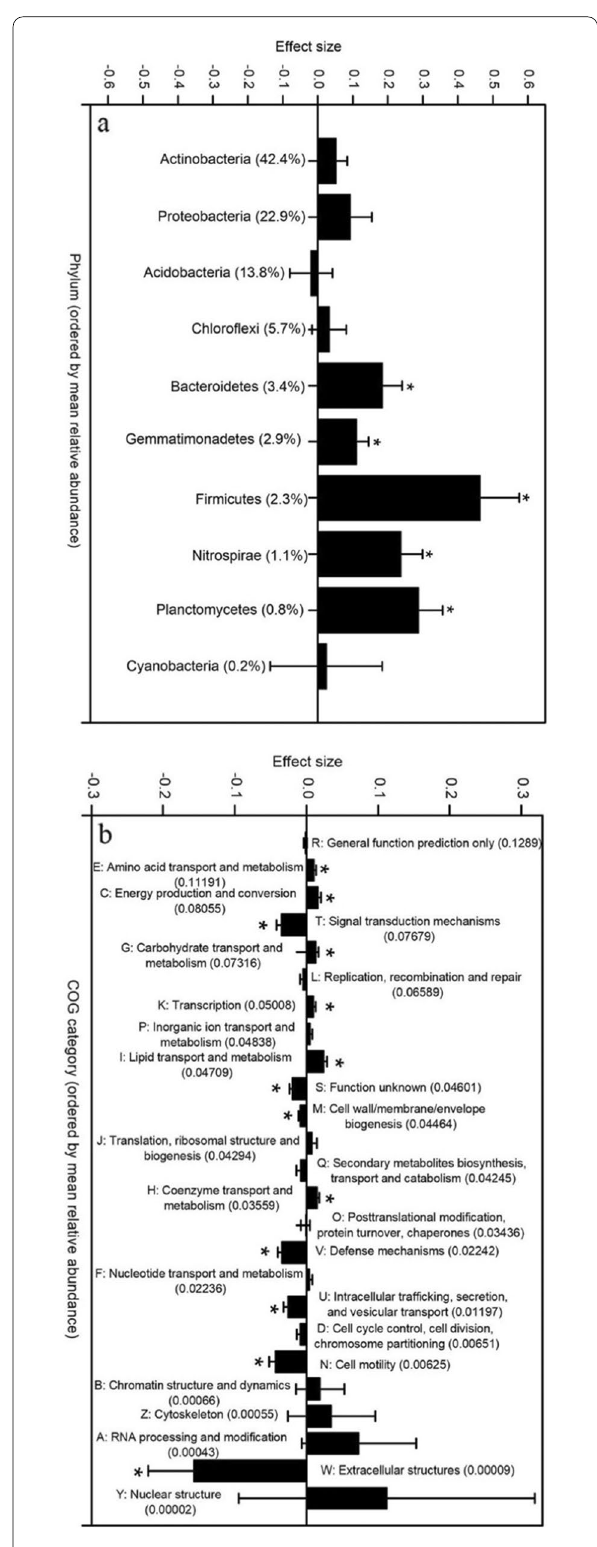
Fig. 1 The effect size of each microbial phylum ( a ) or function ( b ) in the grassland ecosystem under investigation. In b, the functional name is the COG category abbreviation (the capital) and the functional description. The effect size of each phylum under each environmental change is calculated as: ((its mean absolute abundance under environmental change)—(its mean absolute abundance under control))/(its mean absolute abundance under control). The relative abundance is used for the calculation of the effect size of each function. See the detailed value of effect size of each phylum/function under each environmental change in Table S3 and S5. For each phylum/function, the mean and standard error of the effect sizes under 16 environmental changes are shown in the figure. The percentage in the brackets following the phylum/ function name is its mean relative abundance in the entire bacterial community. * denotes instances when the effect size was significantly different from zero (one sample T test: P <